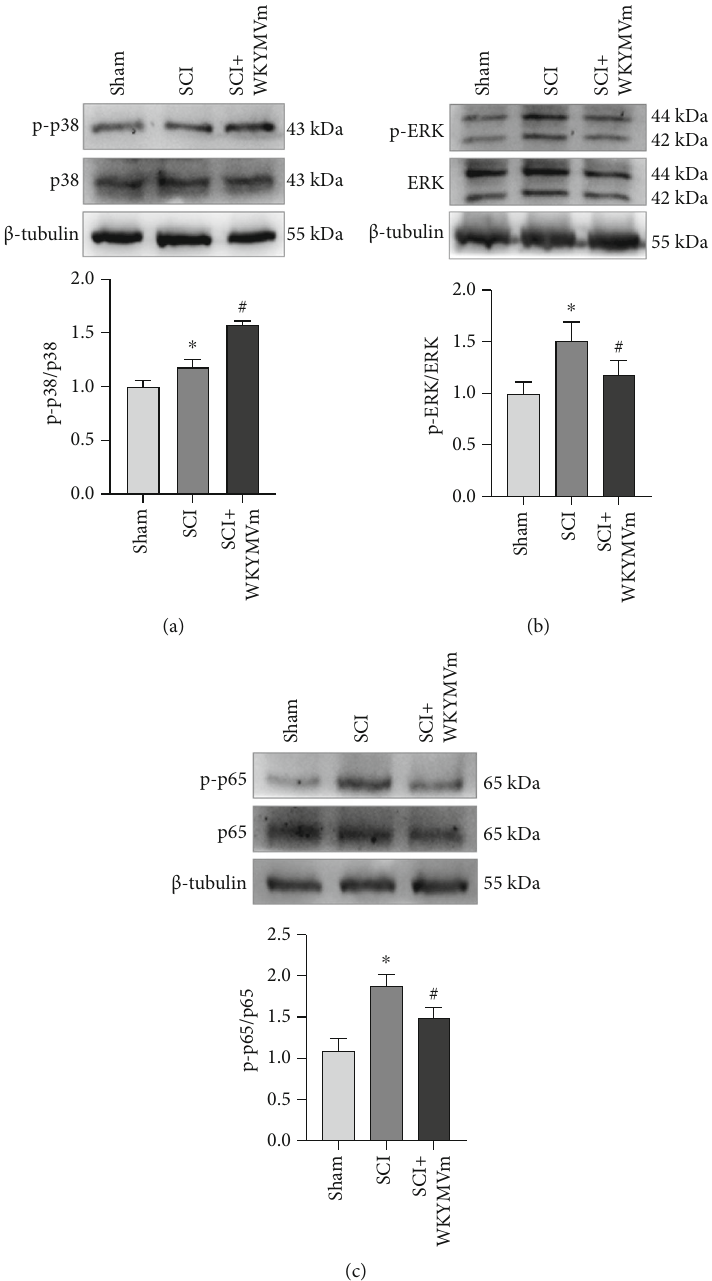
Figure 6: WKYMVm inhibited the ERK1/2 and NF- κ B p65 signaling pathways and a ff ected the p38 signaling pathway after SCI. (a – c) Western blots and quantitative data for p-p38, p-ERK1/2, and p-p65 protein in tissue at 72 h after SCI. ∗ p < 0 : 05 vs. the sham group; # p < 0 : 05 vs. the SCI